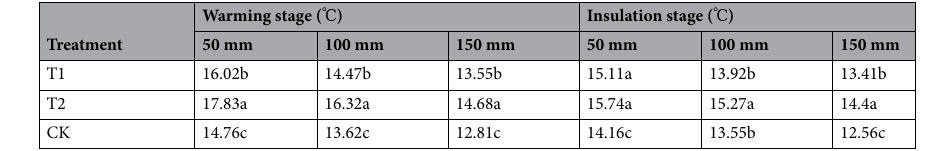
Table 4. Average soil temperature of different treatments. Different lowercase letters followed by the same column among the treatments means significant differences (p < 0.05) according to LSD.